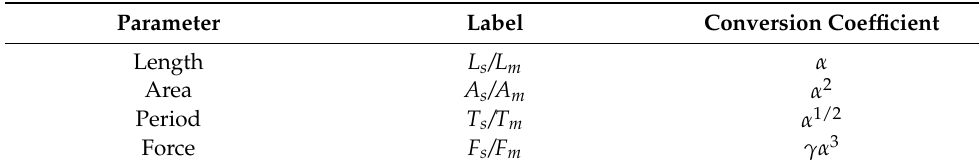
Figure 7. Wave time history of three foundation sizes. ( a ) Foundation size: 1 m. ( b ) Foundation size: 2 m. ( c ) Foundation size: 3 m. Table 5. The transformation ratio according to the Froude similarity.